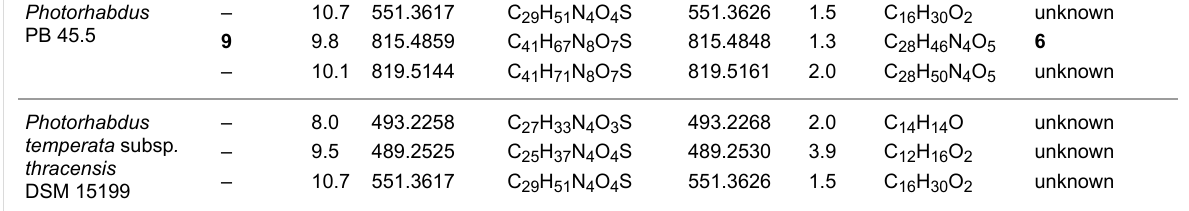
Table 1: Additionally found masses in the tested strains, calculated molecular formulas of possible azide–alkyne cycloaddition products, and the mo- lecular formulas of the putative parent compounds derived from subtraction of the azide and CARR-derived moiety (C 13 H 19 N 4 O 2 S). (continued) Photorhabdus PB